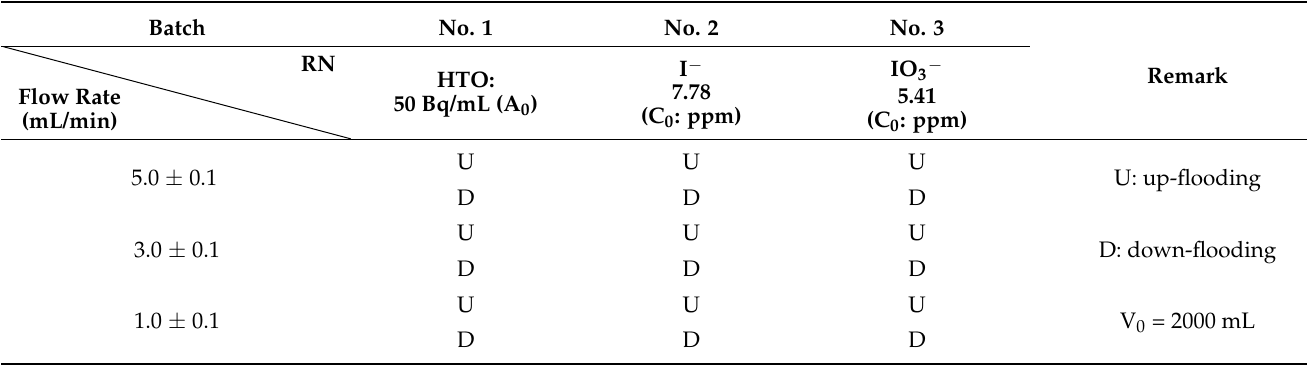
Table 2. ADE experimental process under different flow